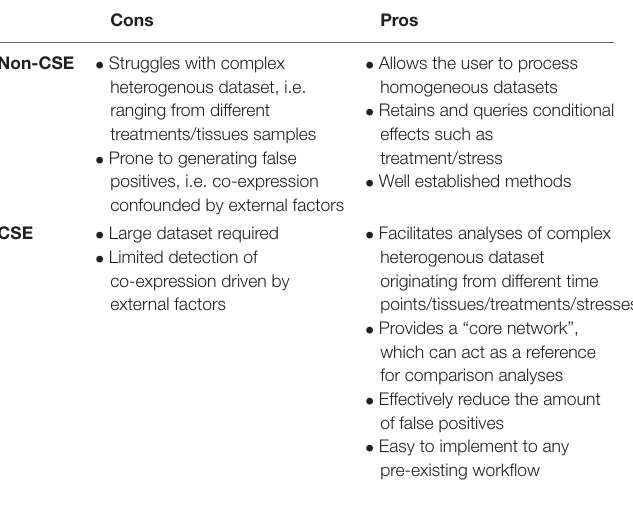
TABLE 1 | Table of pros and cons associated with implementing CSE approaches in GCN analysis. Cons